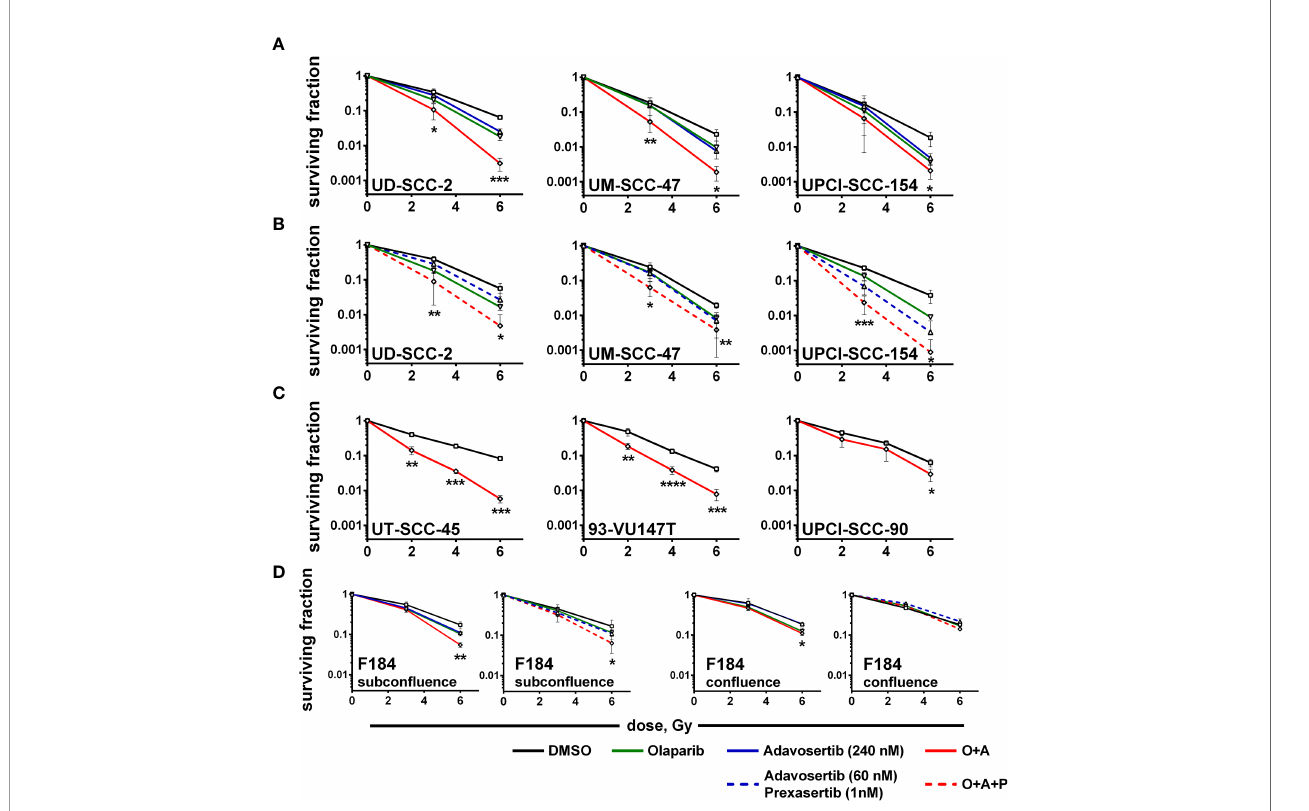
FIGURE 5 | Radiosensitization. Exponentially growing cells were seeded and on the next day treated with inhibitors as indicated and irradiated 2 h thereafter; 24 h later, irradiated cells were seeded in low, de fi ned numbers for colony formation. (A) Radiosensitization of HPV-positive HNSCC cells using dual PARP/Wee1 inhibition or (B) combined PARP/Wee1/Chk1 inhibition. (C) Validation of radiosensitization through combined PARP/Wee1 inhibition using three additional HPV-positive HNSCC cell lines. (D) Effect on normal human fi broblasts as an example of normal tissue cells. Signi fi cance was assessed for solvent control vs . combined PARP + S/G2 checkpoint inhibition. In case of a statistically signi fi cant difference the respective dose points are marked with asterisks with *, **, *** and **** indicating p ≤ 0.05, p ≤ 0.01, p ≤ 0.001, and p ≤ 0.0001, respectively (two-tailed Student ’ s